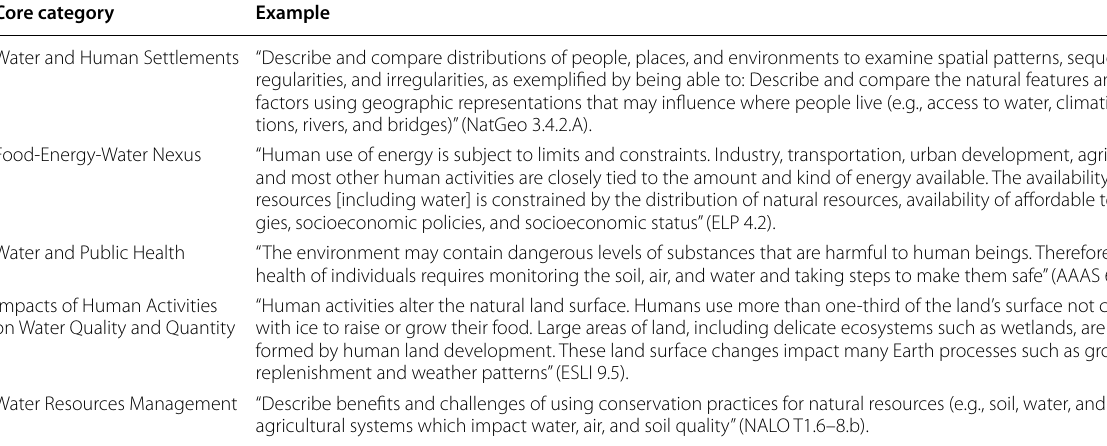
Table 2 Examples of water‑related standards across thematic outcomes Core